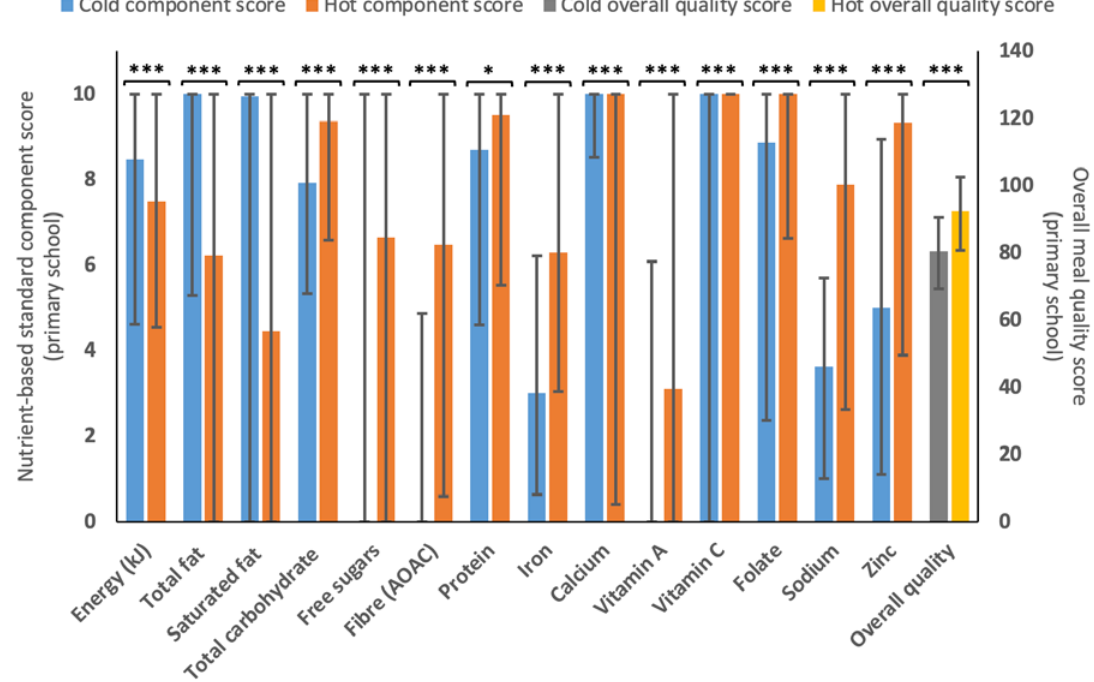
Figure 1. Median (IQR) for the different 5–11-year-old component scores and overall quality score for cold ( n = 1320) and hot ( n = 1439) menu variants. A statistically significant difference is represented by * p < 0.05, and *** p < 0.001), as determined by Mann–Whitney U test.